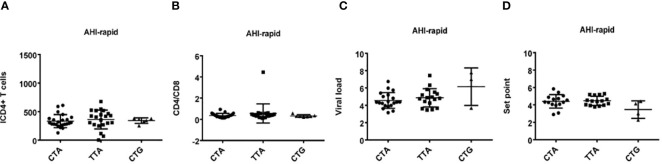
Relationship between haplotypes (CTA/TTA/CTG) and clinical indexes in AHI patients with rapid progression. (A–D) There are four clinical parameters including, ICD4 (initial CD4 T cells) (A), CD4/CD8 (the ratio of CD4 versus CD8 T cells) (B), viral load (C) and set point (D), The y axis indicates the values of these four respective parameters. The x axis, indicates three AHI–rapid patient groups with TLR7 CTA/TTA/CTG haplotype. Each dot represents an MSM individual, (●) represents individuals with TLR7 CTA haplotype. (■) represents individuals with TLR7 TTA haplotype. (▲) represents individuals with TLR7 CTG haplotype.